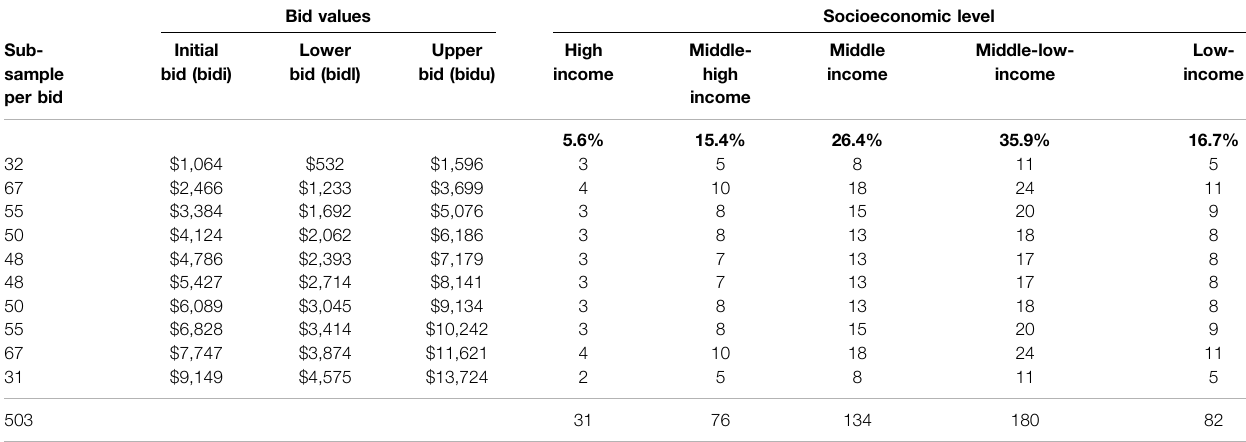
Bid values Socioeconomic level